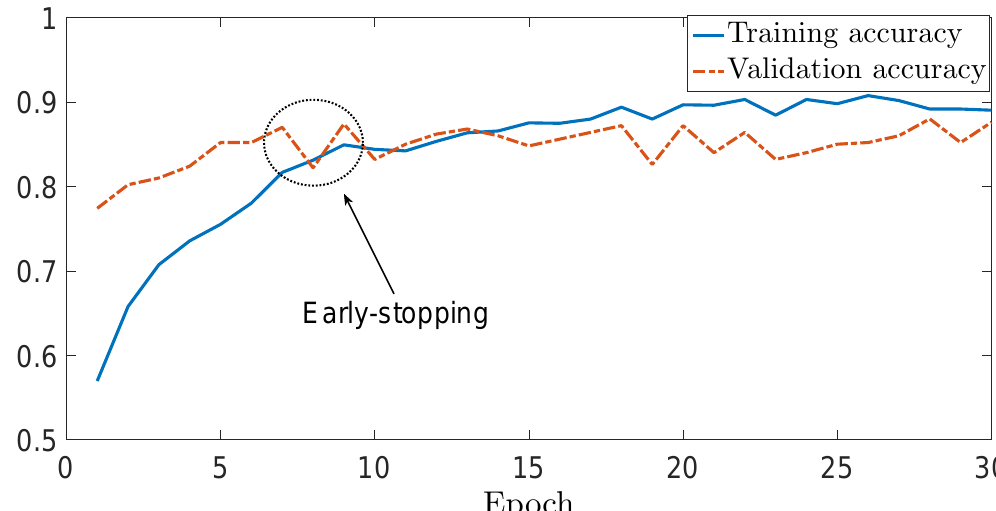
Figure 9. The variation of training accuracy and validation accuracy for the NN model M 0.1 , where early-stopping is activated at the 8th epoch of